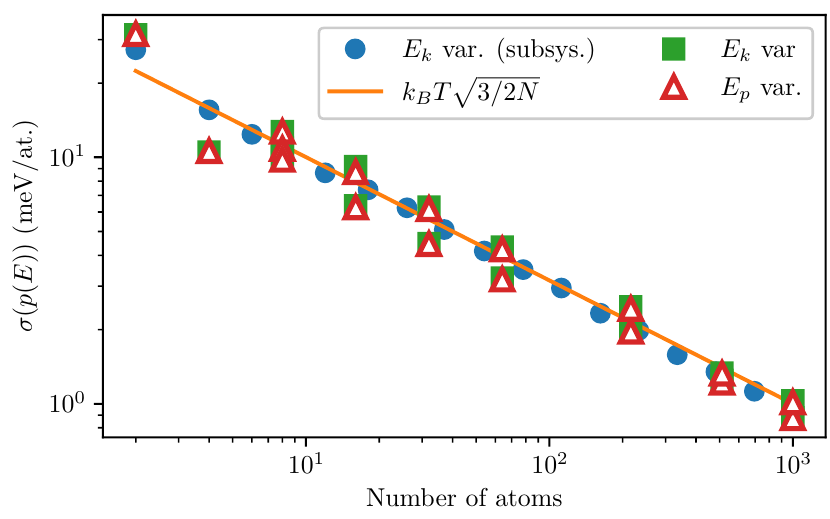
Figure 1: Variance of the energy distribution as a function of system size compared with prediction of the central limit theorem (orange line). Results for different num- bers of randomly chosen coordinates of 5 × 5 × 5 system (blue circles) were put together with variance of both the kinetic (green squares) and potential (red trian- gles) energies of smaller systems (defined in the text). Data extracted from MD run at T = 300